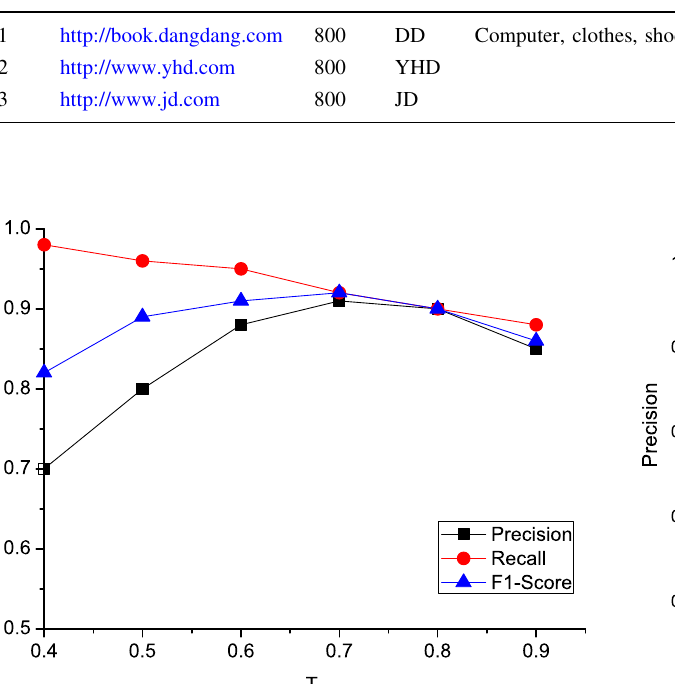
Fig. 7 Precision comparison